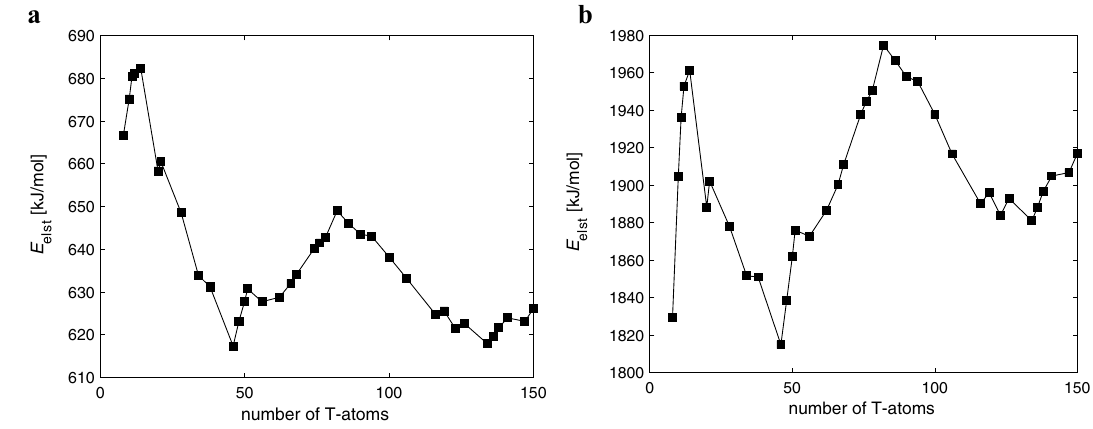
Figure 5. Comparison between ( a ) PBE/def2-SVP electrostatic potential and ( b ) electrostatic potential calculated from formal charges for model clusters of CHA